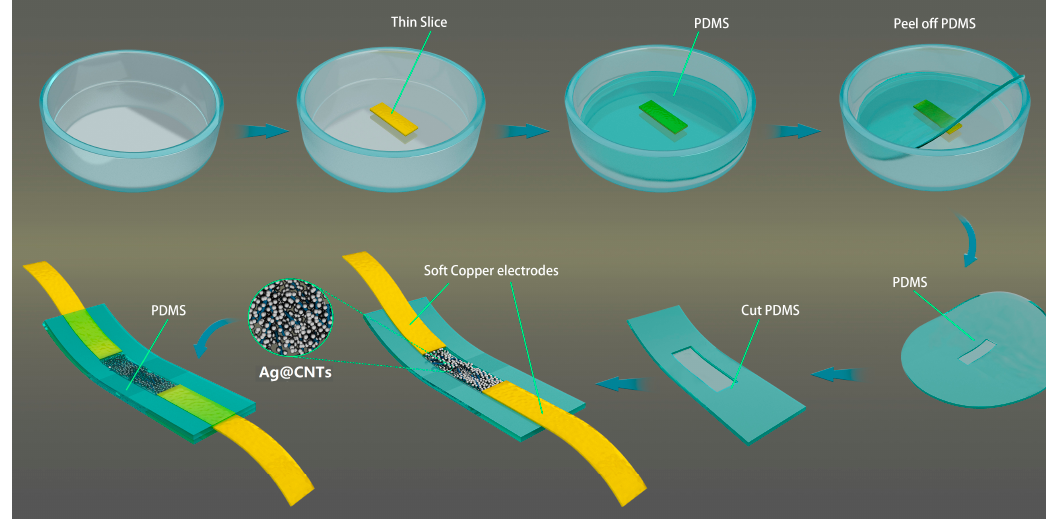
Figure 1. Schematic of the structural design and fabrication process flowchart of the sensor.